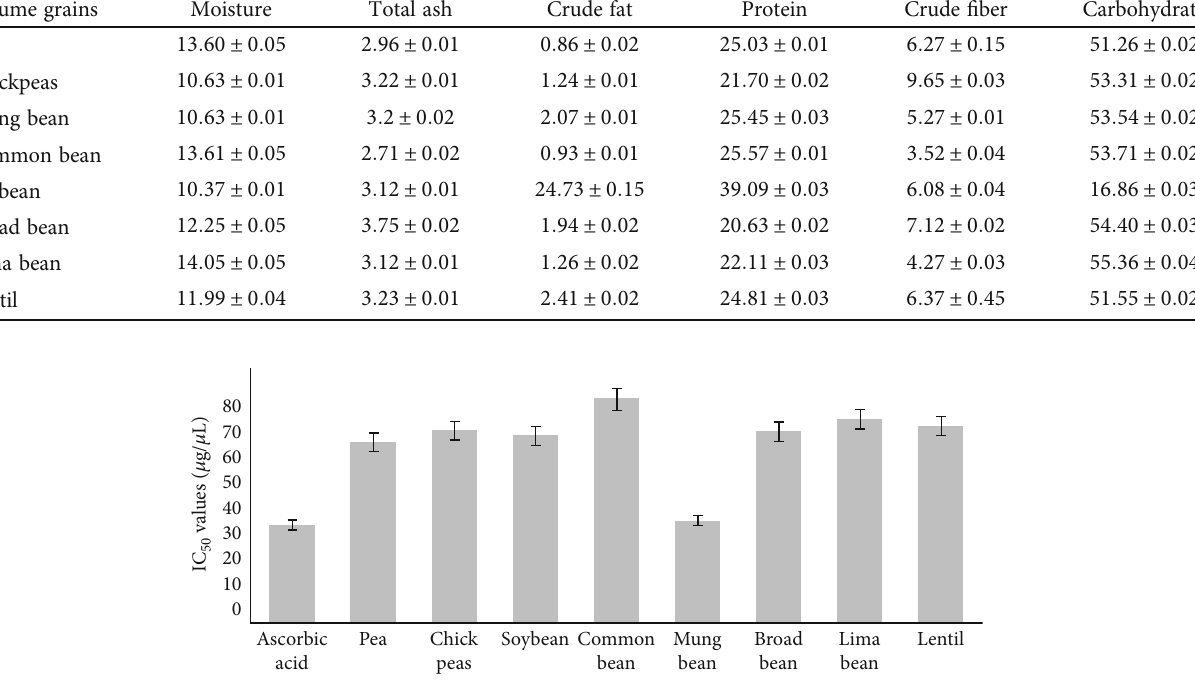
Figure 2: The IC values for antioxidant activity of legumes grains and standard ascorbic 50